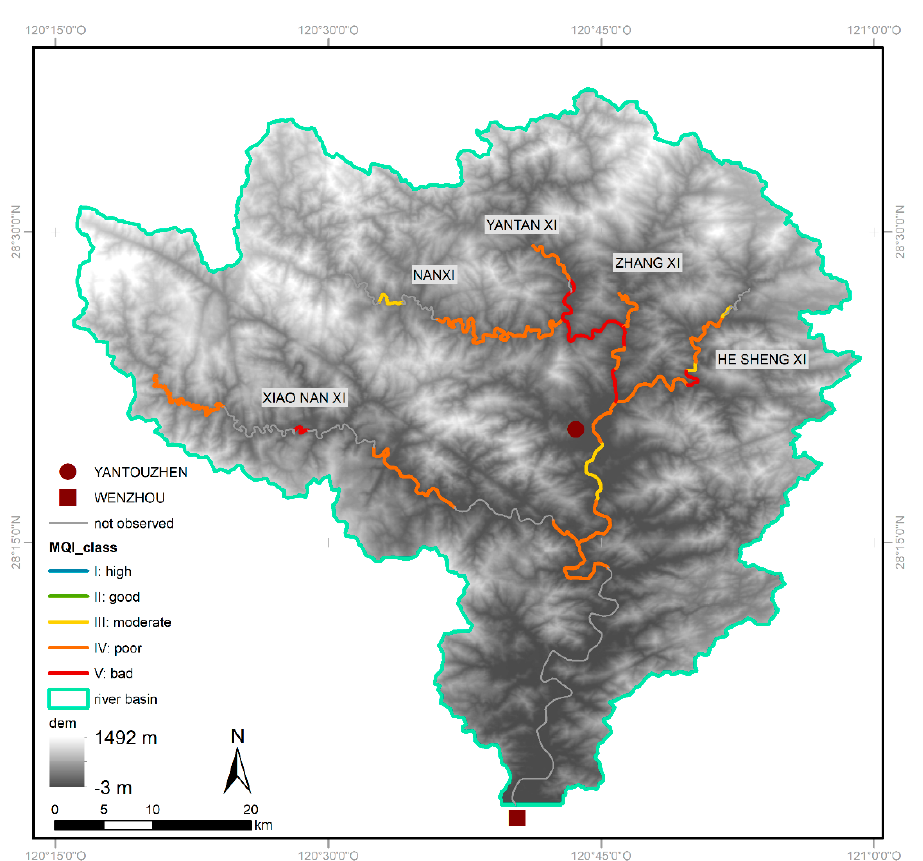
Figure 5. Hydromorphological status of the Nanxi river basin assessed by an adapted approach of the MQI method for the rivers Nanxi (classification concerning the share of the observed length: III: 14%, IV: 67%, V: 19%), Xiao Nan Xi (IV: 94%, V: 6%), He Sheng Xi (III: 13%, IV: 75%, V: 12%), Zhang Xi (IV: 100%), and Yantan Xi (IV: 52%, V: 48%).